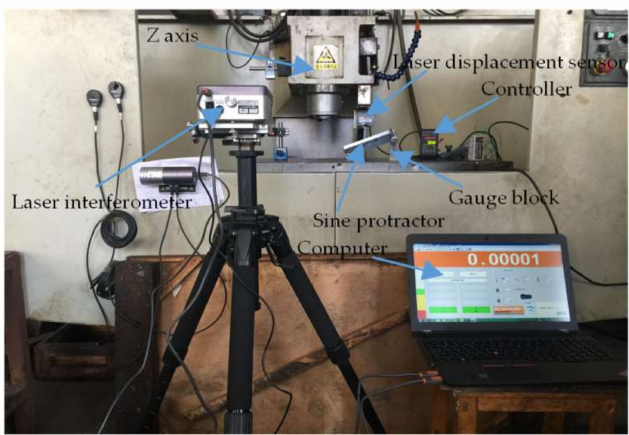
Figure 8. The experiment of inclination error.